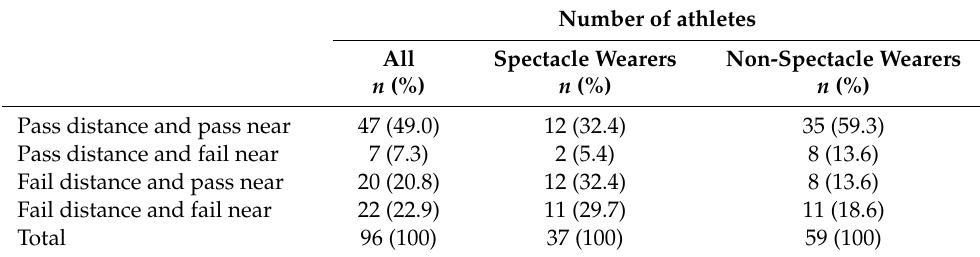
Table 4. Athletes passing the VA criteria (Distance: VA better than 0.3 logMAR monocular; Near: VA better than 0.3 logMAR binocular).